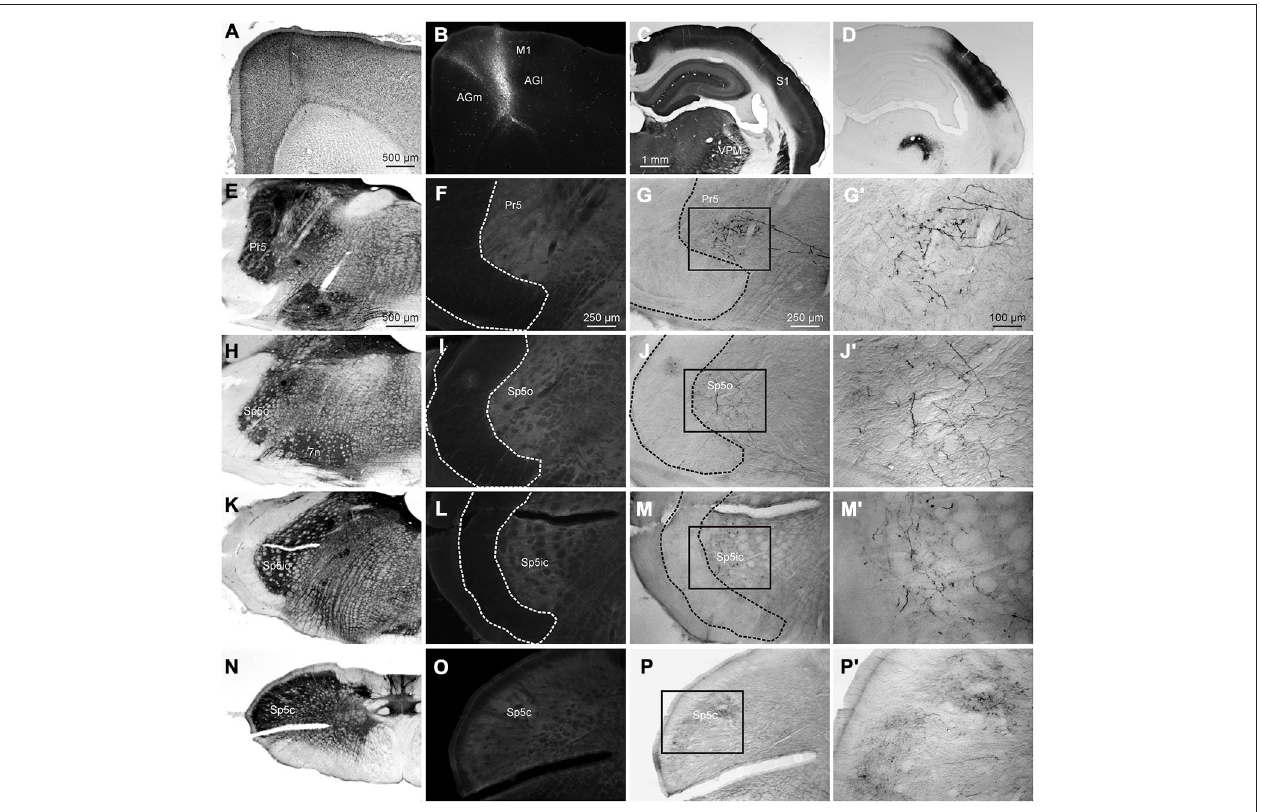
FIGURE 9 | A representative example of a case receiving dual anterograde tracer deposits into the M1 and S1 cortices. (A) Nissl stained coronal section through the cortex showing the track of the pipette used to inject FR into M1. (B) Injection site of FR into vibrissal representation of the M1 cortex. (C) Coronal section through S1 barrel cortex processed for CO labeling. (D) Adjacent section, processed for visualization of BDA showing injection site in S1 and associated anterograde labeling. Anterograde labeling can be seen in ventral posterior medial nucleus (VPM). (E) Coronal section through the brainstem at the level of Pr5 stained for CO for better visualization of nuclear boundaries and neural tracts. (F) Adjacent section processed for visualization of FR terminals showing lack of any labeled terminals. (G) Adjacent section processed for visualization of BDA labeled terminals showing the presence of labeled varicosities in Pr5. (G (cid:48) ) Inset from (G) shown at greater magnification. (H–J (cid:48) ) Identical photomicrographs from the brainstem at the rostrocaudal level of Sp5o. (K–M (cid:48) ) Sections from the level of Sp5ic. (N–P (cid:48) ) Sections from the level of